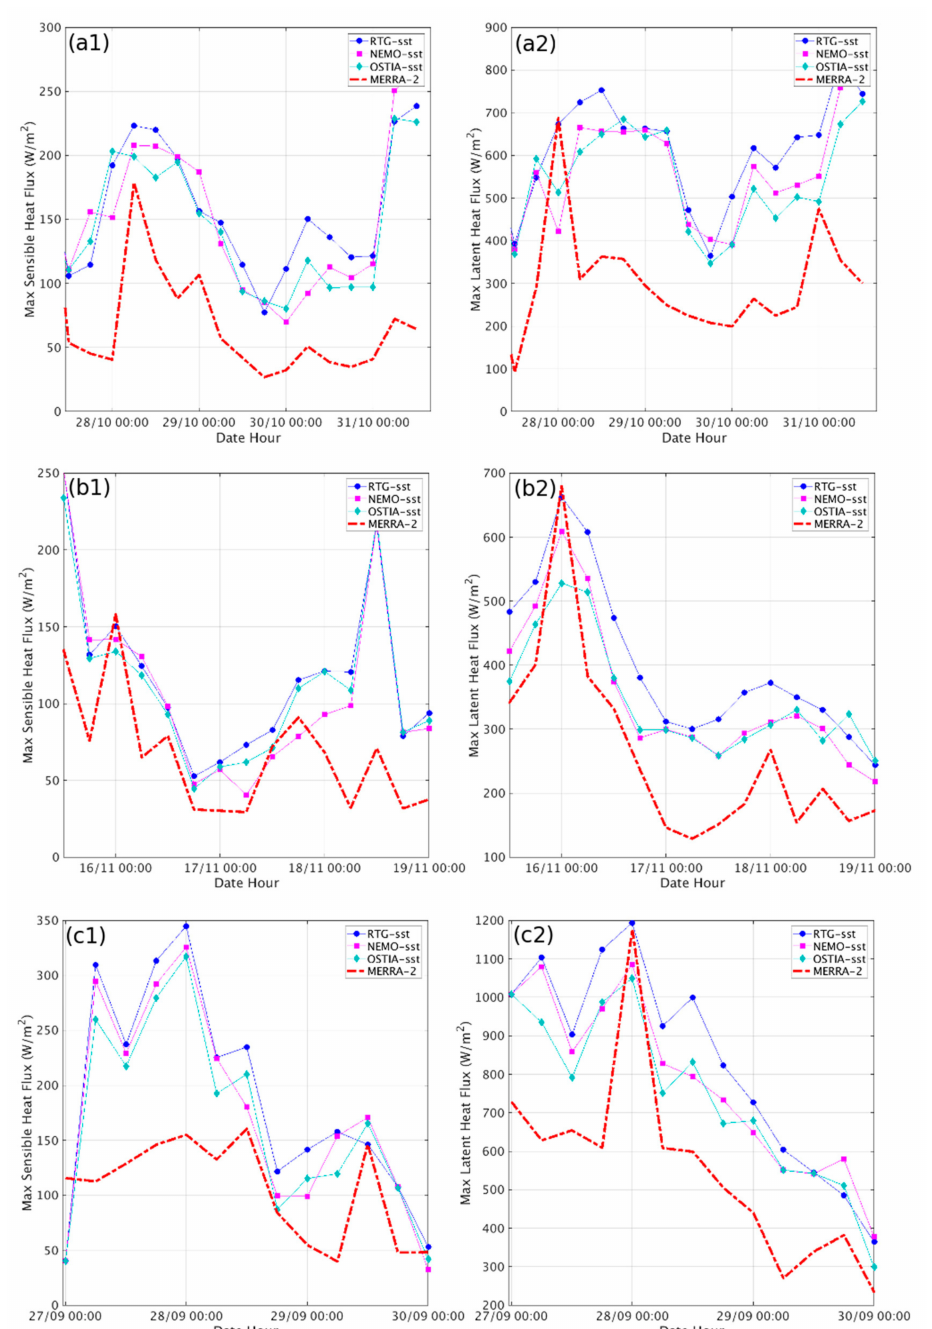
Figure 12. Maximum sensible heat and latent heat fluxes from RTG-sst, NEMO-sst, and OSTIA-sst simulation and MERRA-2 reanalysis in six-hour intervals during ( a1 – 2 ) cyclone Trixi, ( b1 – 2 ) cyclone Numa, and ( c1 – 2 ) cyclone